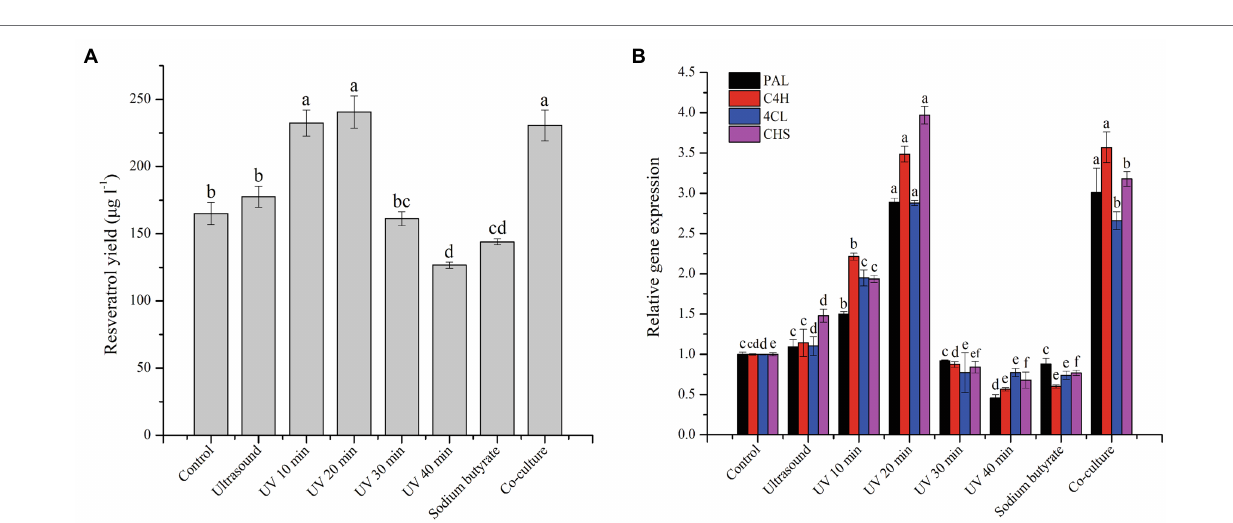
FIGURE 2 | Effect of different elicitors on the resveratrol production (A) and the expression of key genes in the pathway (B) . Values with different letters indicate a significant difference (Duncan, p <